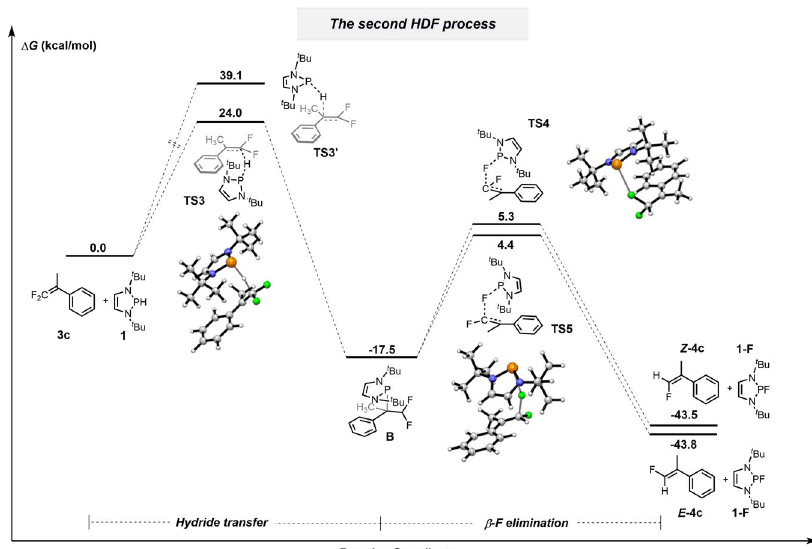
Fig. 9 Mechanistic investigations for the second HDF process by DFT calculations. Energy pro fi les for HDF of 3c by 1 in acetonitrile calculated at the